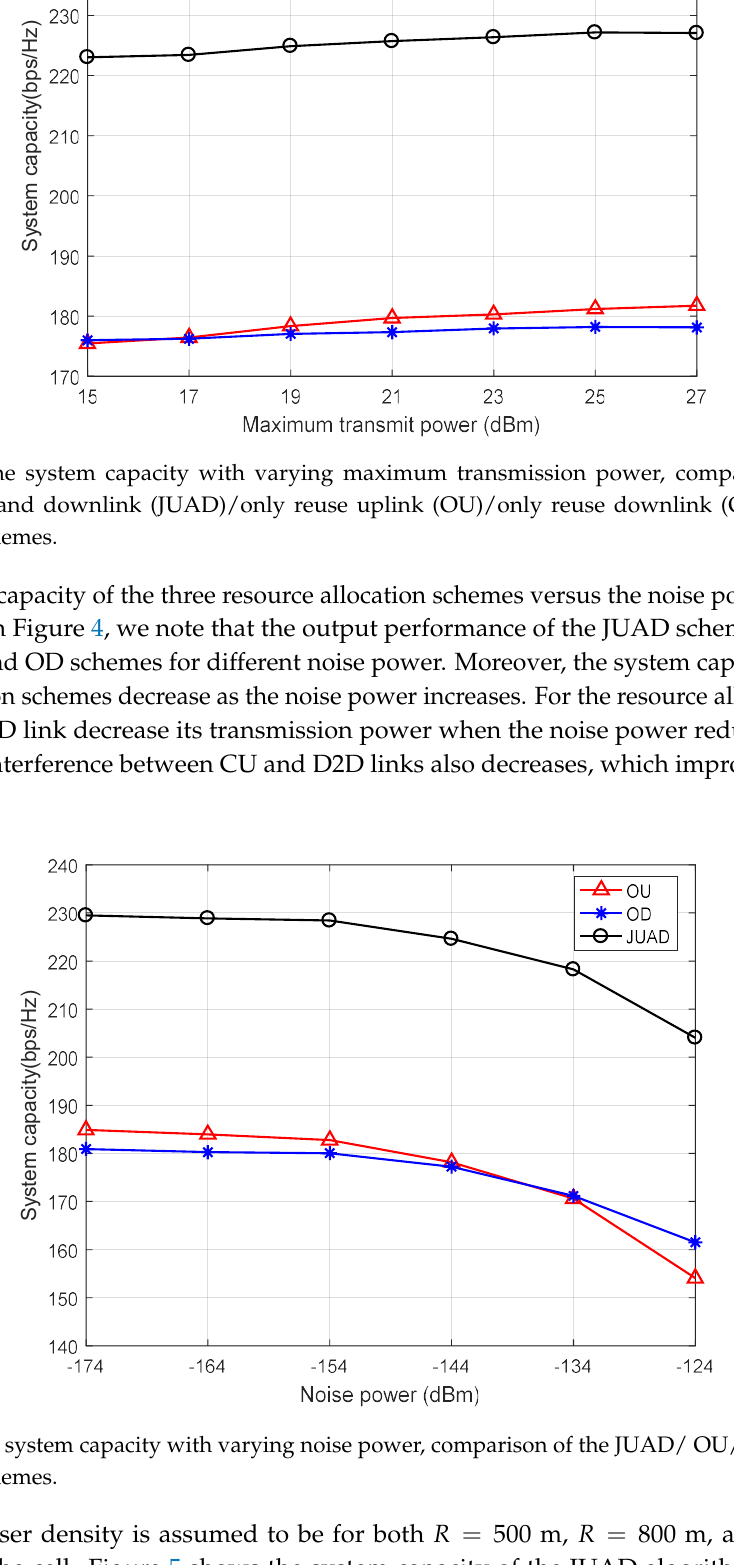
Figure 5. The system capacity versus different maximum transmission power with different cell radius. The system capacity of the three resource allocation schemes for different distances of D2D pairs is shown in Figure 6. It can be seen that the system capacity decreases with the increasing radius of the D2D pair. As distance of D2D pairs is equal to 70 m, the system capacity that JUAD scheme can achieve is more than 220 bps/Hz, which is about 125% higher than that of the OU and OD schemes. In the range of the distance D2D pairs from 30 m to 90 m, our JUAD resource allocation scheme has superior performance to the other two schemes.